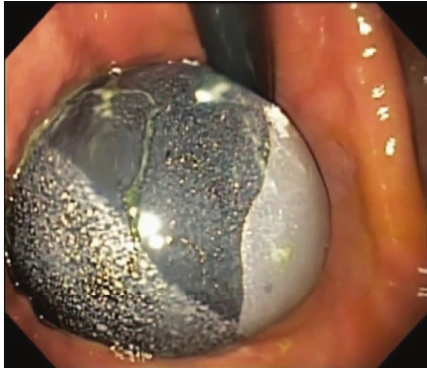
Figure 1: Endoscopic view (in retroflexion) of an intragastric bal- loon immediately after